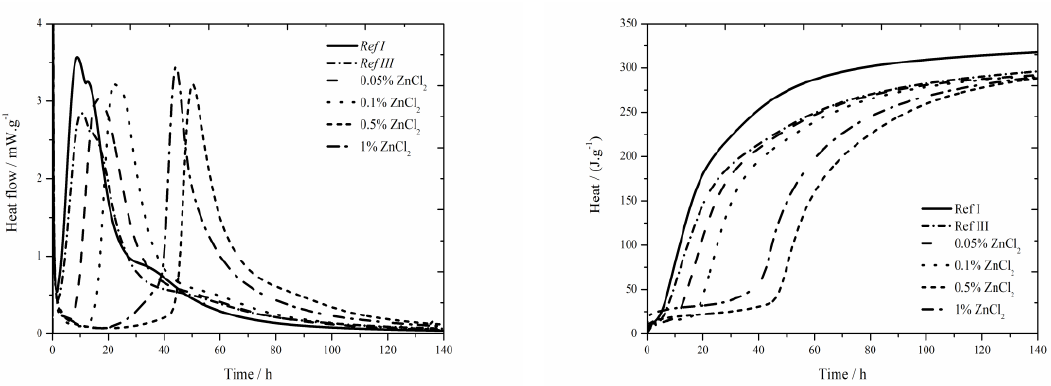
Figure 4. Isothermal curves for ZnCl 2 samples.